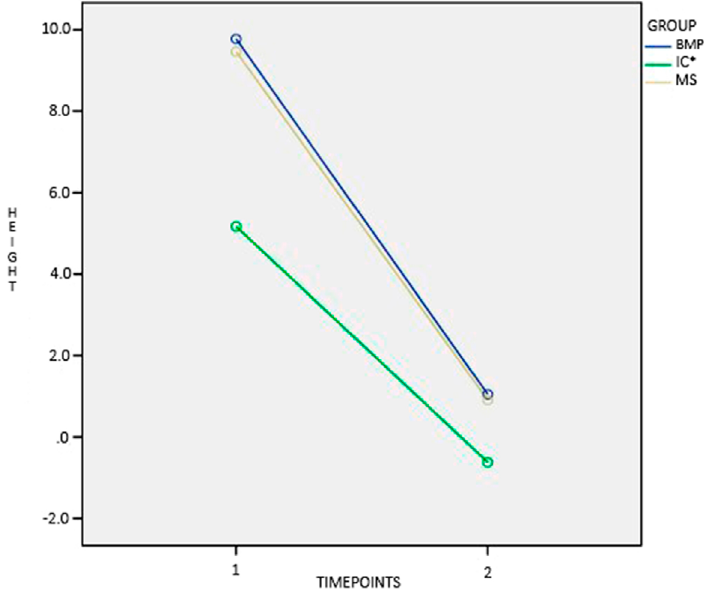
Figure 2- Interaction of time for PCCSs height (mm) from the occlusal